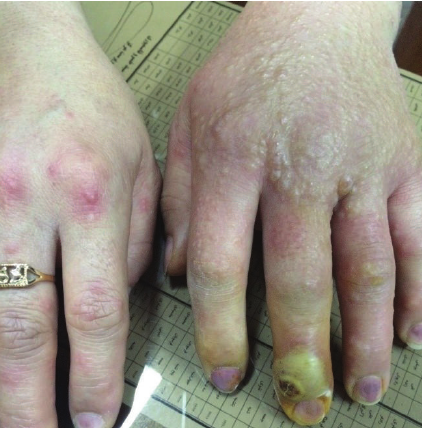
Figure 1: Orf lesion and papulovesicular rash one day before admission.